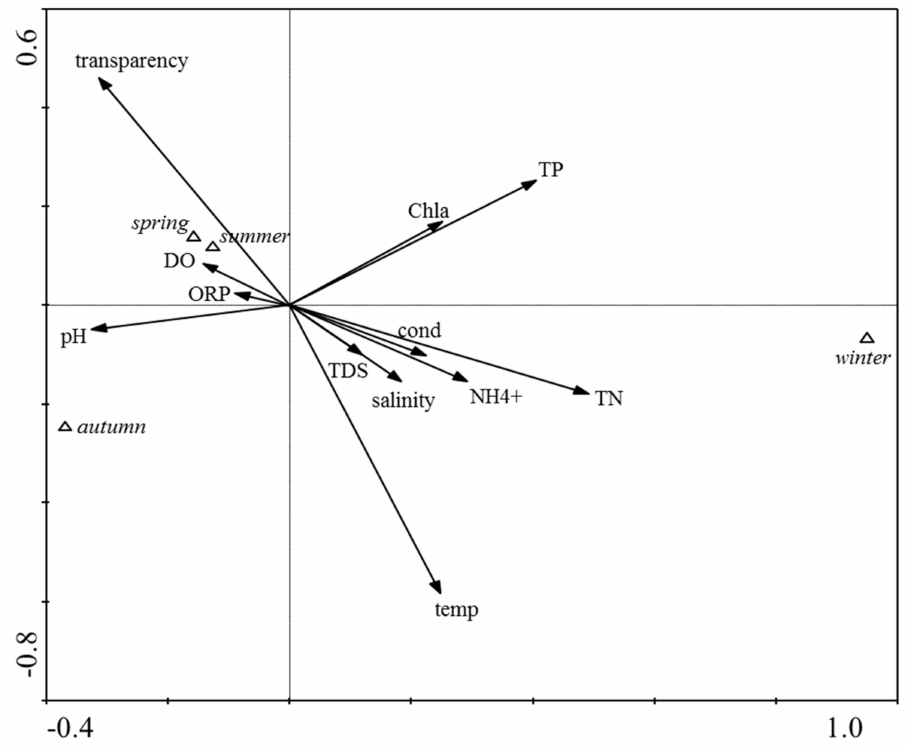
Figure 6. Two-dimensional descending graph of the abundance of Brachionus calyciflorus and envi- ronmental